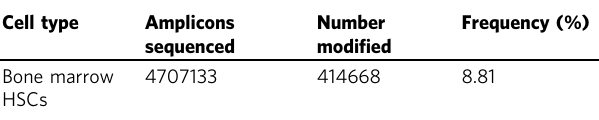
Table 2 Deep sequencing analysis of E18.5 HSCs from the bone marrow of γ tcPNA/DNA NP treated fetal